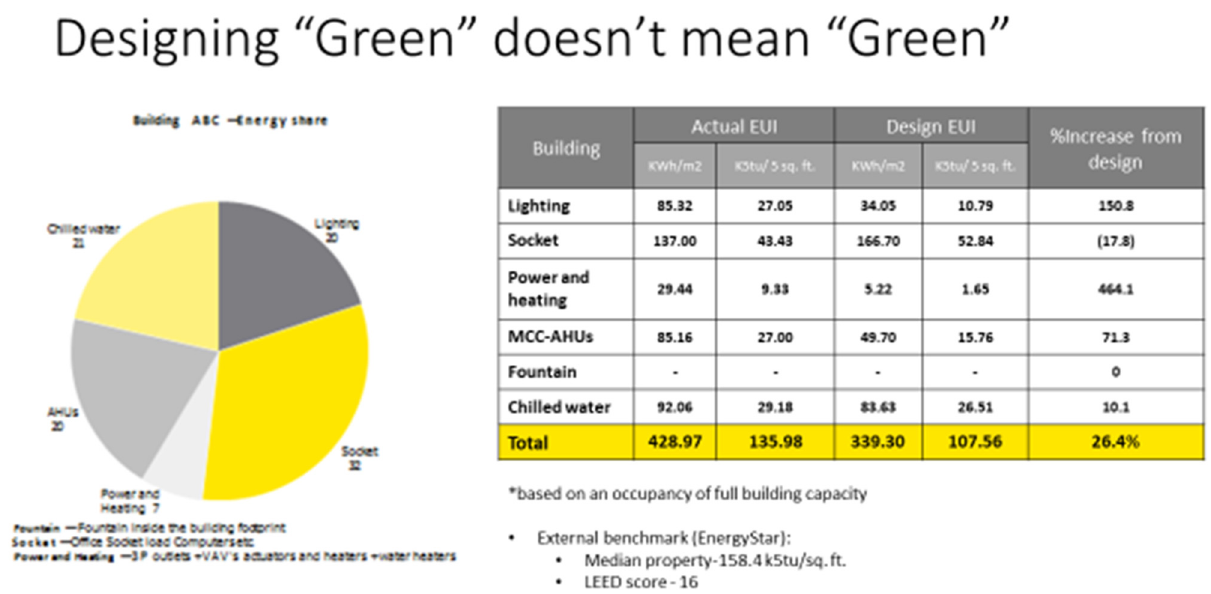
Fig. 6. Green building design based on an occupancy of total building